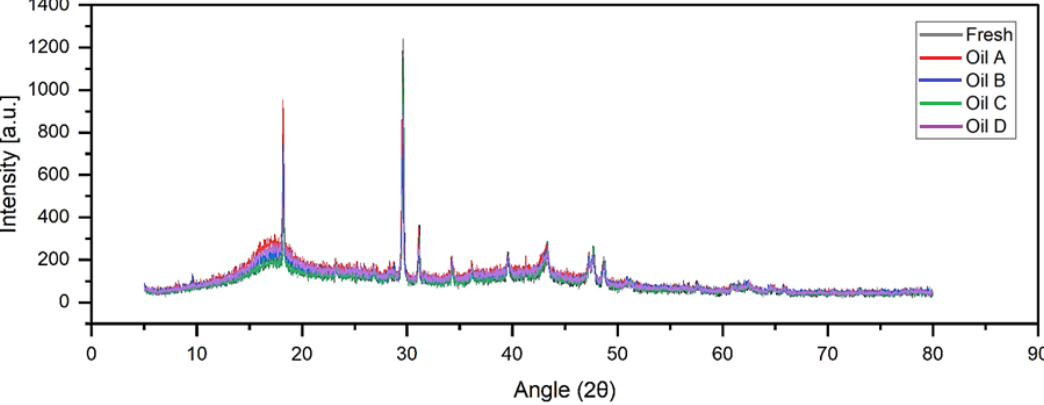
Figure 5. XRD spectra expressed in arbitrary units (a.u.) for the FKM (fresh and after 168 h of aging).